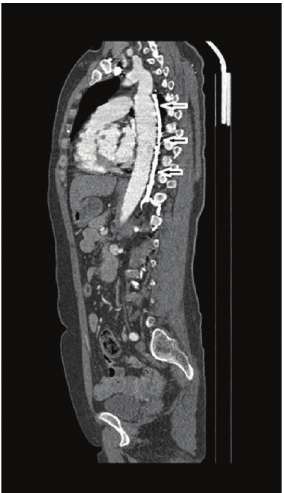
Figure 6: The left azygos vein in sagittal MPR image